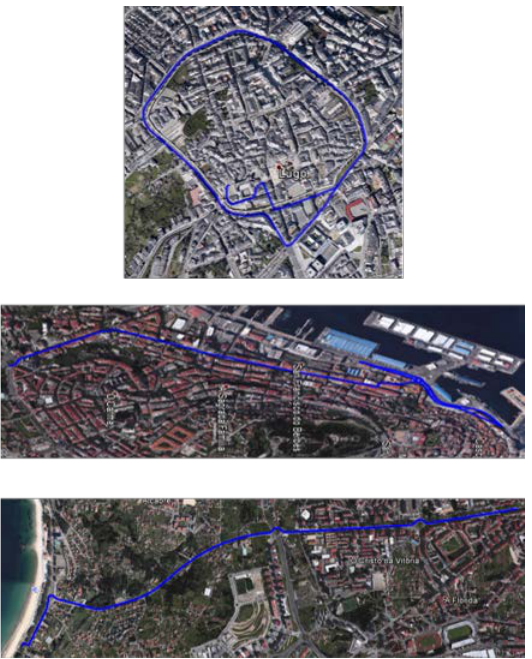
Figure 6. Case study data was acquired from three areas in two different cities located in the northwest of Spain.